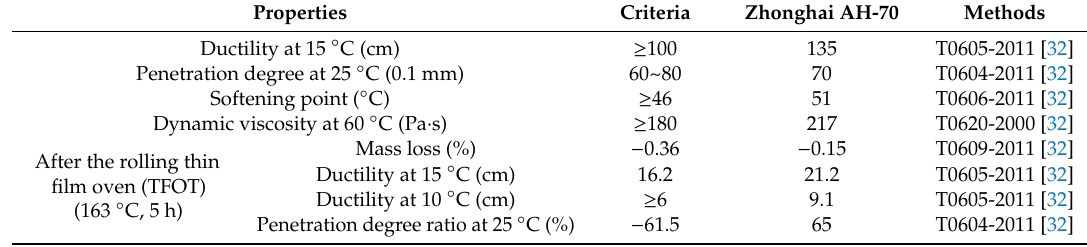
Table 1. Asphalt properties.